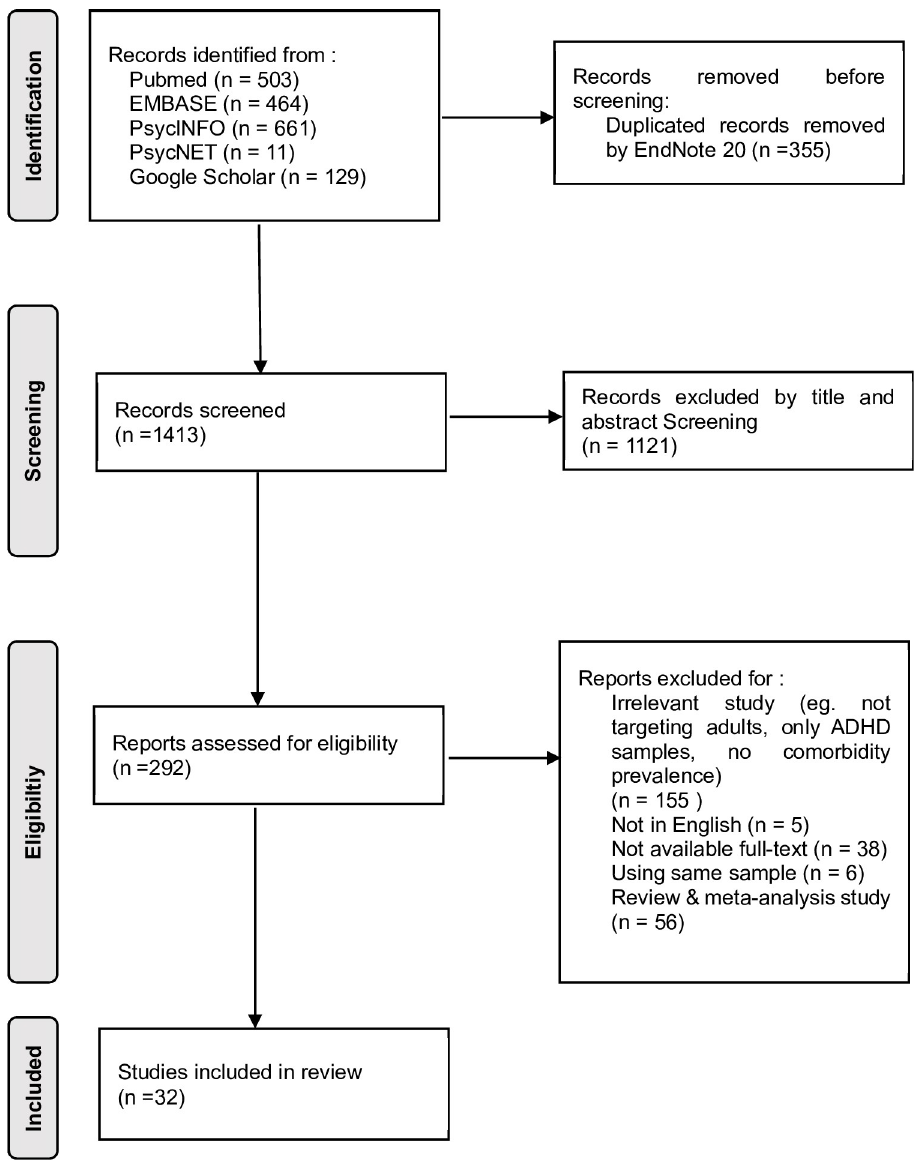
Fig 1. PRISMA flow diagram. Flow diagram of the manual screening process for eligible